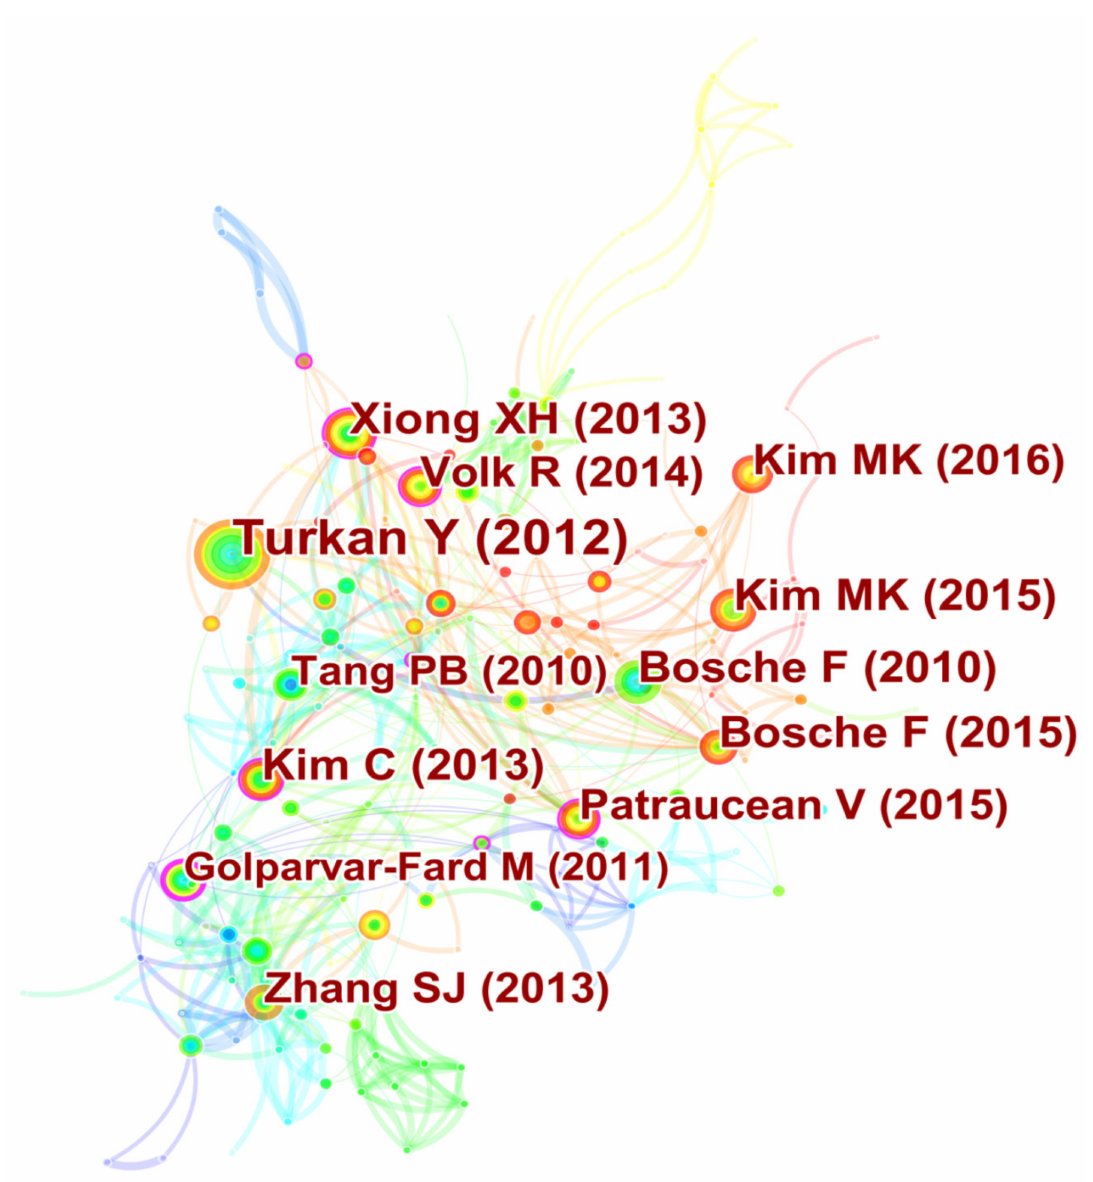
Figure 6. Network of document